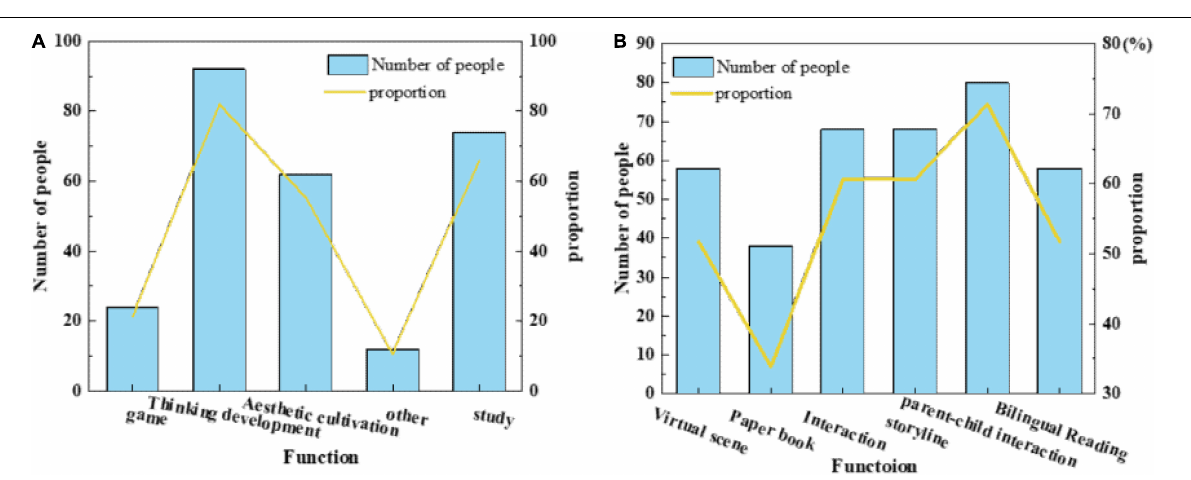
FIGURE 10 | Parents’ expectations of AR children’s picture books. (A) The functions that parents want AR children’s picture books to have. (B) Parents think that AR children’s picture books need to pay attention to the design and development